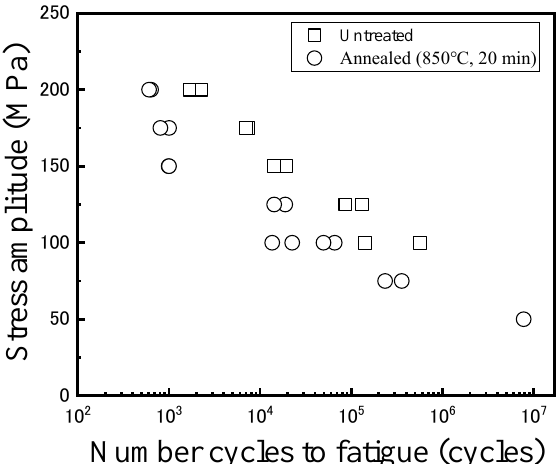
Figure 5. Low cycle fatigue test results.